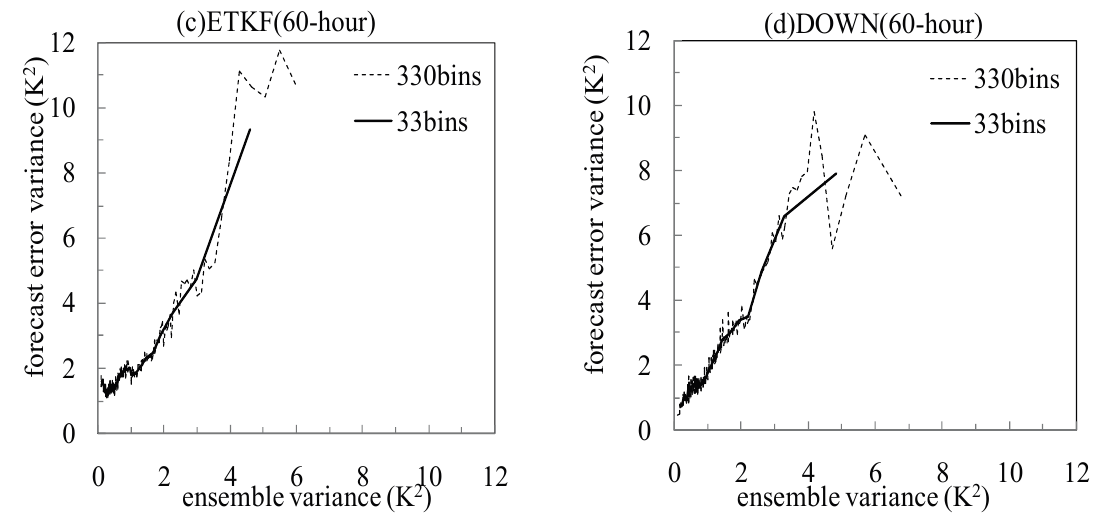
Figure 5. Relationship between the 500 hPa temperature ensemble perturbation variance and forecast error variances with the value averaged from each of 33 bins (solid lines) and 330 bins (dotted lines) at all grid points. ( a ) ETKF 6 h forecast; ( b ) DOWN 6 h forecast; ( c ) ETKF 60 h forecast; ( d ) DOWN 60 h